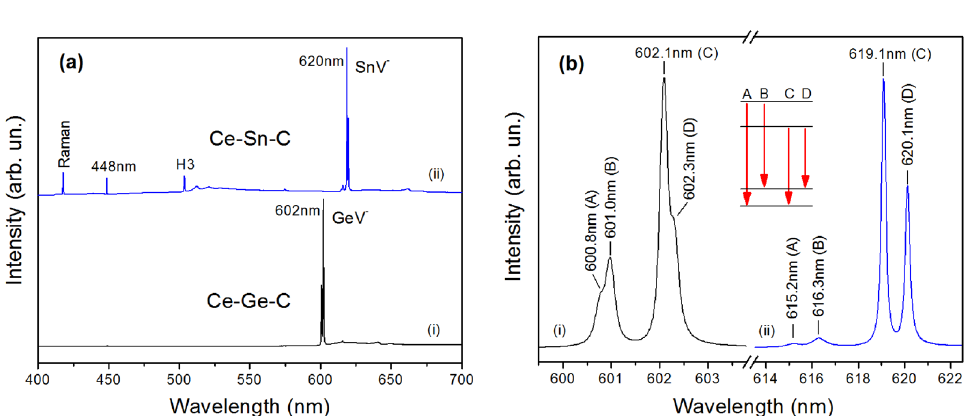
Figure 7. PL spectra of diamonds synthesized from the Ce catalyst with Ge and Sn additives. ( a ) Overview PL spectra of diamonds from (i) Ce–Ge–C and (ii) Ce–Sn–C systems. The spectra were recorded at 80 K with excitation of 395 nm and displaced vertically for clarity. ( b ) PL spectra in the region of zero-phonon lines of (i) GeV − and (ii) SnV − centers. The inset shows schematic structure of electronic transitions at the